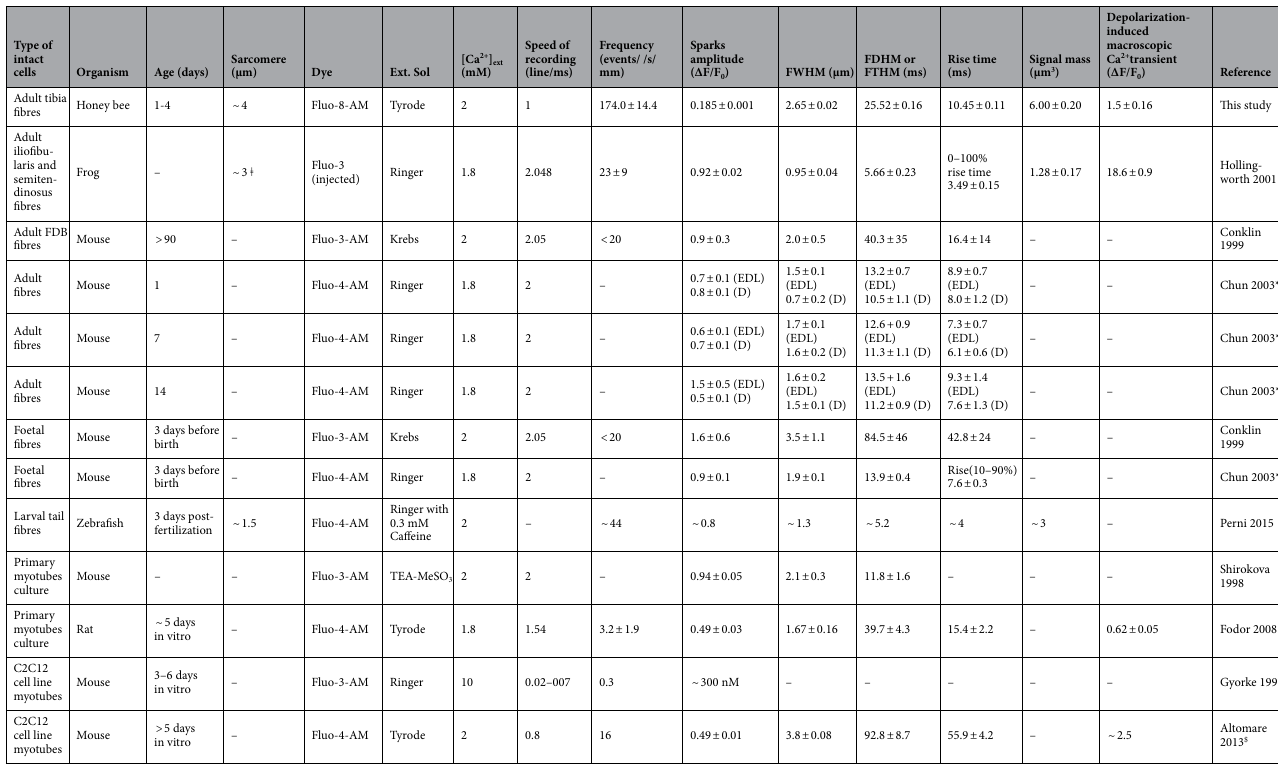
Table 3. Interspecific comparison of calcium sparks’ and depolarization-evoked transients’ parameters measured in line-scan (XT) experiments performed in intact cells. In this table studies are ordered according to i) the developmental stage (from adult to foetal/larval stages) and ii) the species (Honey bee, Frog, Mouse, Rat, Zebrafish). All preparations were freshly isolated muscle fibres except the last four where the cells were in cell culture. *Chun values are from P1, P7, and P14 EDL muscle and from foetal (3 days before birth) diaphragm, rise time was calculated between 10–90% of the peak amplitude. ǂ sarcomere stretched to ~ 3 µm. $ parameters of CREs originate from sparks and embers together. Data marked with ~ is approximated from figures. All data depicted at room temperature except Perni et al. 2015 (18 °C). Hollingworth et al. 2001 cooled the fibres to 17–20 °C. All studies were from intact cells bathed in a physiological solution (Ringer, Krebs or Tyrode), except for Perni et al. 2015 (caffeine added) and Shirokova et al. 1998 (150 TEA-MeSO 3 ) 57 . FDB – flexor digitorum brevis; EDL – extensor digitorum longus; D- diaphragm; AM – acetoxymethyl ester; FWHM – full width at half maximum; FDHM – full duration at half maximum; FTHM – full time at half